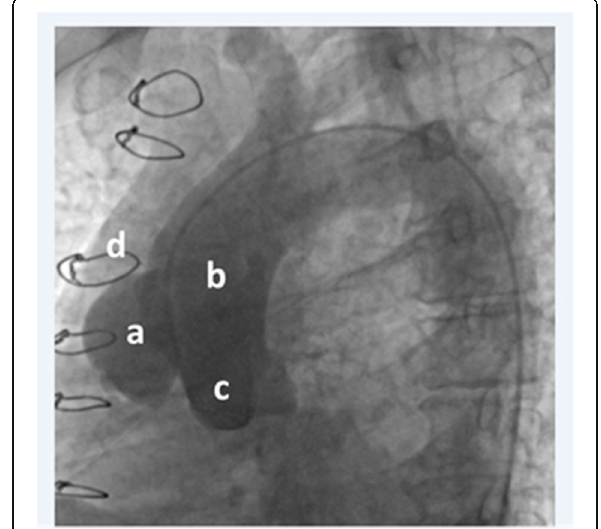
Fig. 1 Electrocardiogram-gated CT angiography in oblique coronal plane depicts a contrast-filled outpouching from the proximal ascending aorta just above the sinotubular junction in favor of Pseudoaneurysm ( A ) Pseudoaneurysm, ( B ) ascending aorta